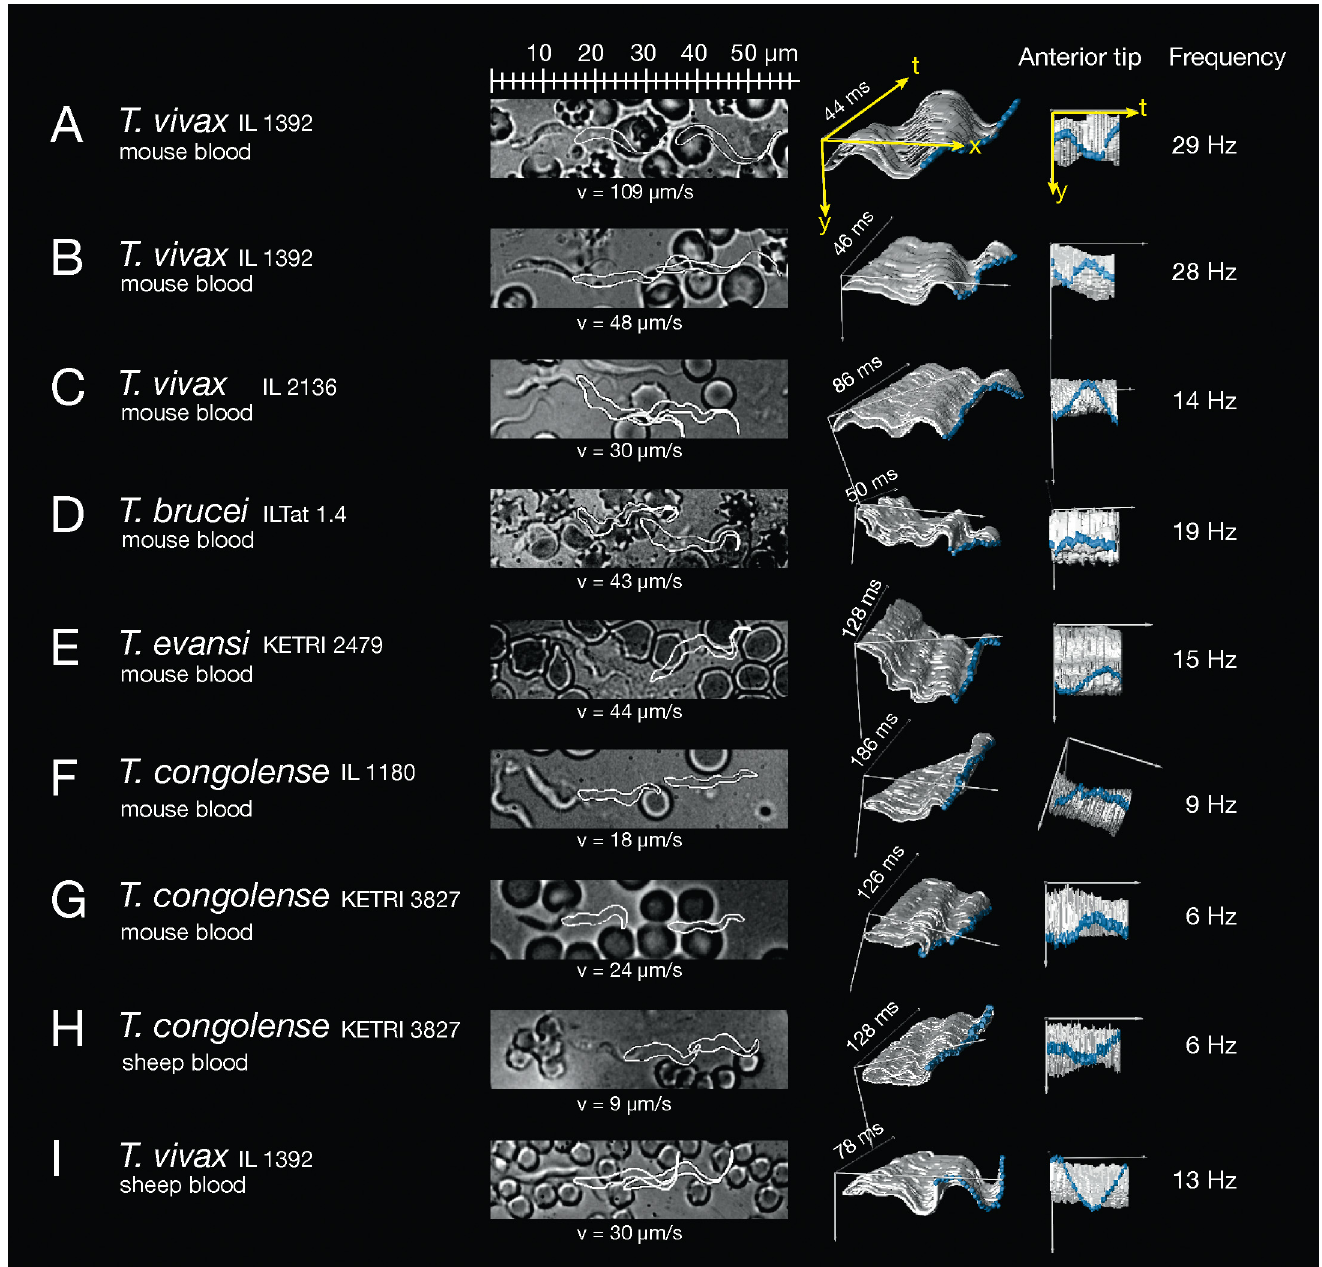
Fig 4. High-resolution single cell analysis of persistently swimming trypanosomes. The images on the left are single frames of the corresponding S8 – S16 Videos, showing the cells at the beginning of an analysed flagellar beat, while two later positions of the parasites are shown as white outlines to depict the trajectory of the cell. The speed (v) is the highest average velocity reached during the video sequence analysed. The panel to the right presents the trypanosome outlines from each recorded frame for one complete flagellar beat. The successive image frames were stacked along the time axis in a three- dimensional surface representation. This allows the visualisation of the cellular waveform produced by the beating flagellum and the attached cell body. The anterior tip of the flagellum is marked in blue. The duration of the complete flagellar beat is annotated on the t-axis (ms). The right panel reveals the same 3D- surface representation, however, turned to view on to the anterior tip of the flagellum (along the x-axis of movement). This illustrates the sinusoidal oscillation of the flagellar tip, starting the travelling wave running along the body to the posterior end. The average frequency (Hz) of the flagellar beats of the analysed video is given on the right (see Materials and Methods). A) A representative slim waveform of T . vivax IL 1392 swimming forward with continuous tip-to-base beats in a wet blood film from the mouse (S8 Video). This waveform represents a small subset (1%) within the parasite population and swims significantly faster than cells exhibiting normal waveforms. B) Normal waveform of T . vivax IL 1392 in mouse blood from S9 Video, swimming with a frequency similar to that of the fast waveform in A) but reaching less than half the speed. C) T . vivax IL 2136 in mouse blood reveals slower motion when compared to the IL 1392